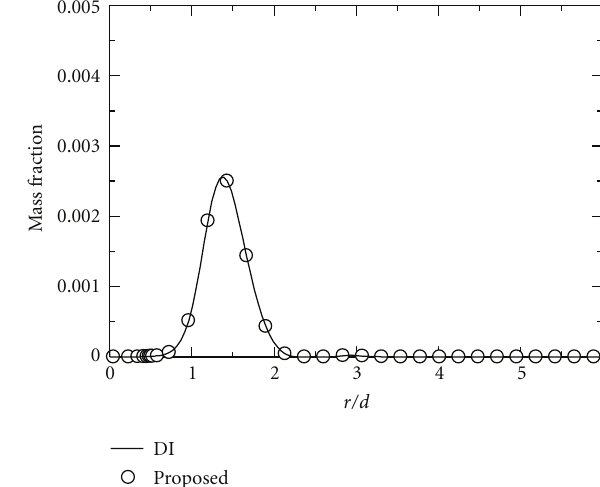
Figure 9: Radial mass fraction of OH at x/d = 10.